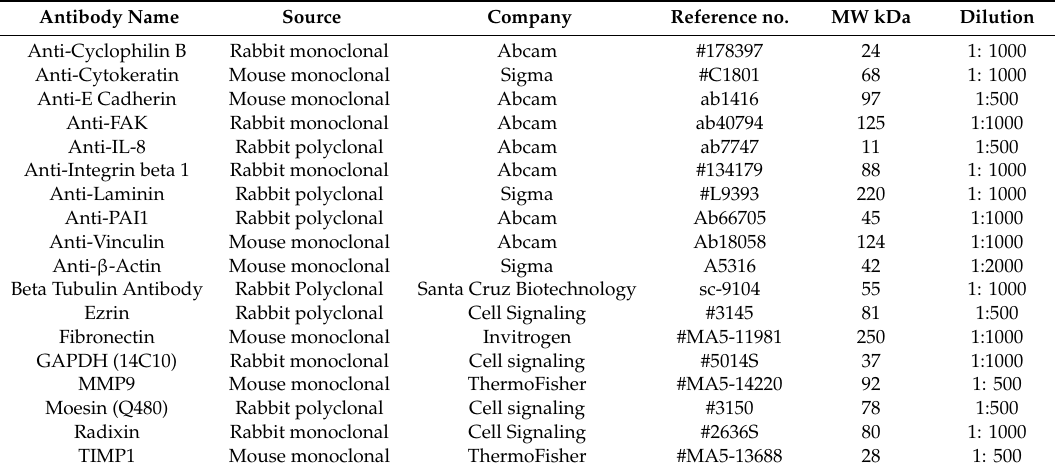
Table 3. List of the names, sources, companies, molecular weight and dilutions of all the antibodies that were used for Western